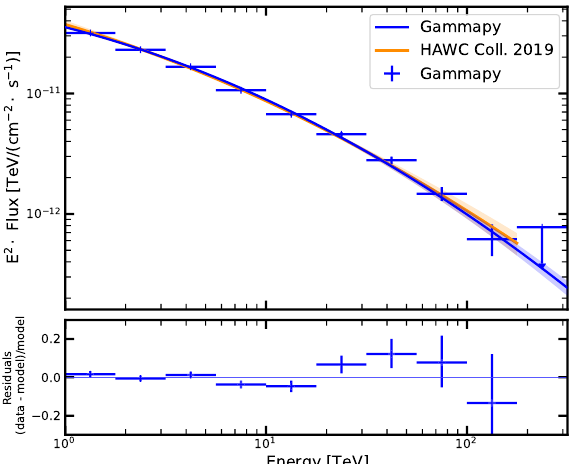
Figure 7. Estimated flux spectrum of the Crab Nebula derived from the GADF data production using Gammapy (blue) compared against the reference HAWC spectrum from [47] (orange). The bottom panel shows the residual comparison of the obtained flux points with the reference spectrum. Figure from